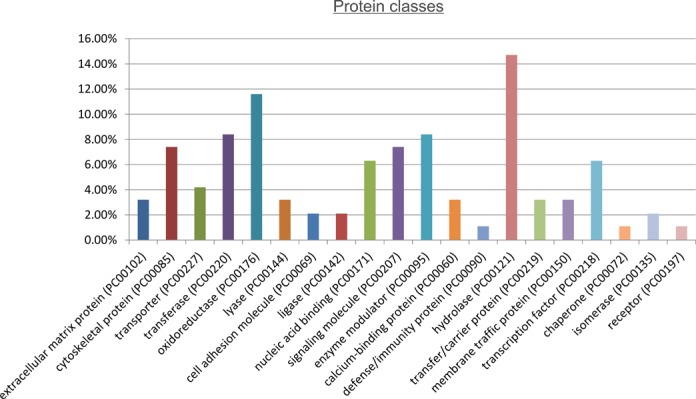
Classification of proteins that were differently expressed in DIO1(+) cells when compared with DIO1(-) cells.The graph shows results of analysis performed using PANTHER (http://pantherdb.org).